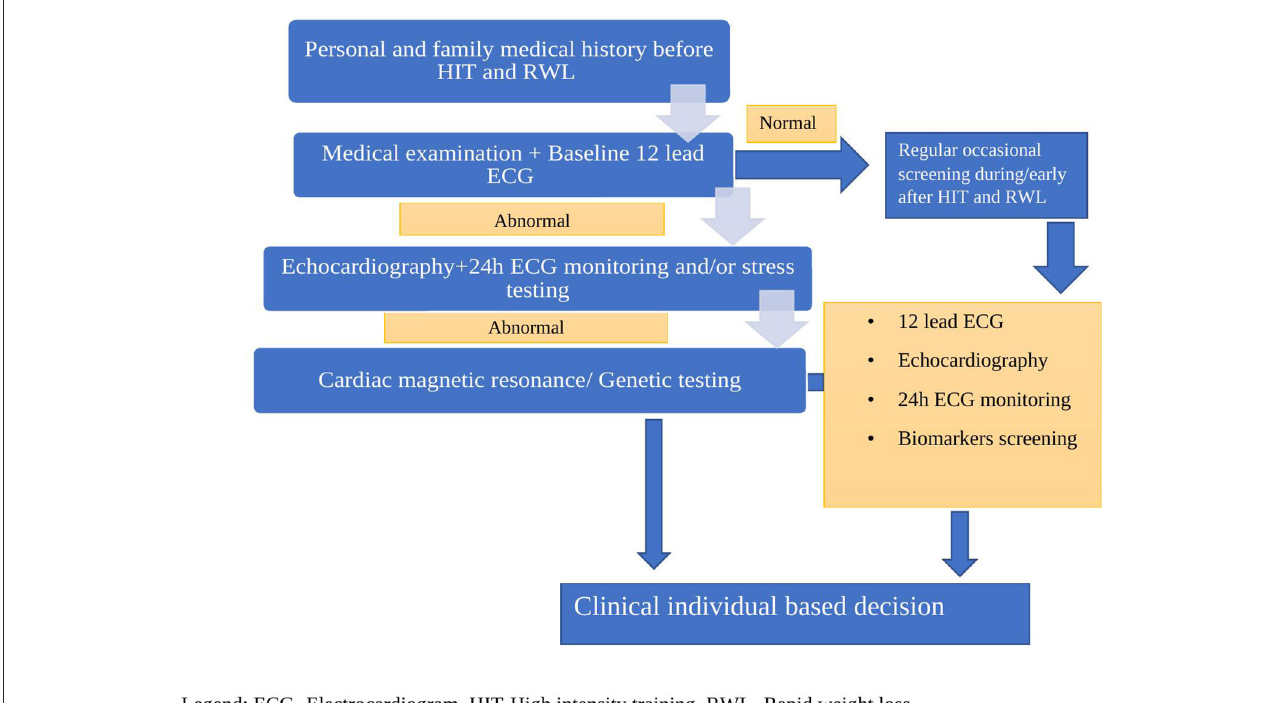
FIGURE3 Suggested cardiovascular screening for athletes engaged in HIT and